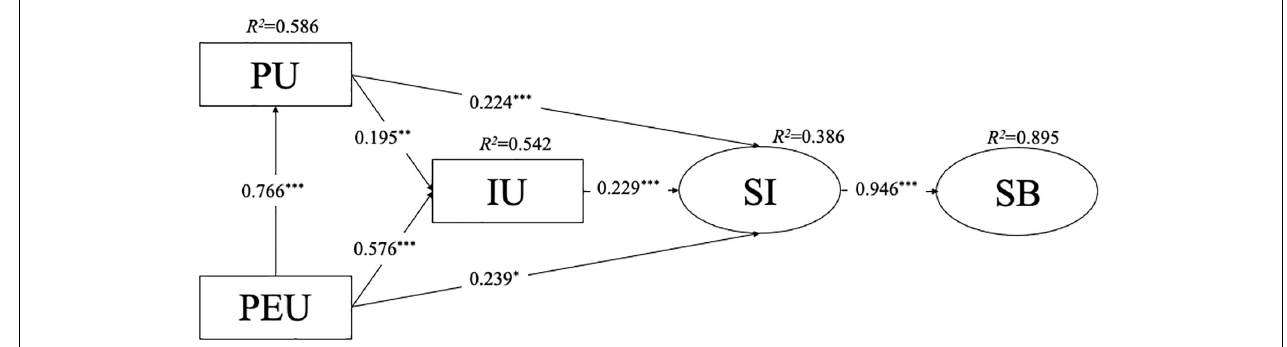
FIGURE 2 | Research model results. * p < 0.05, ** p < 0.01, *** p < 0.001.